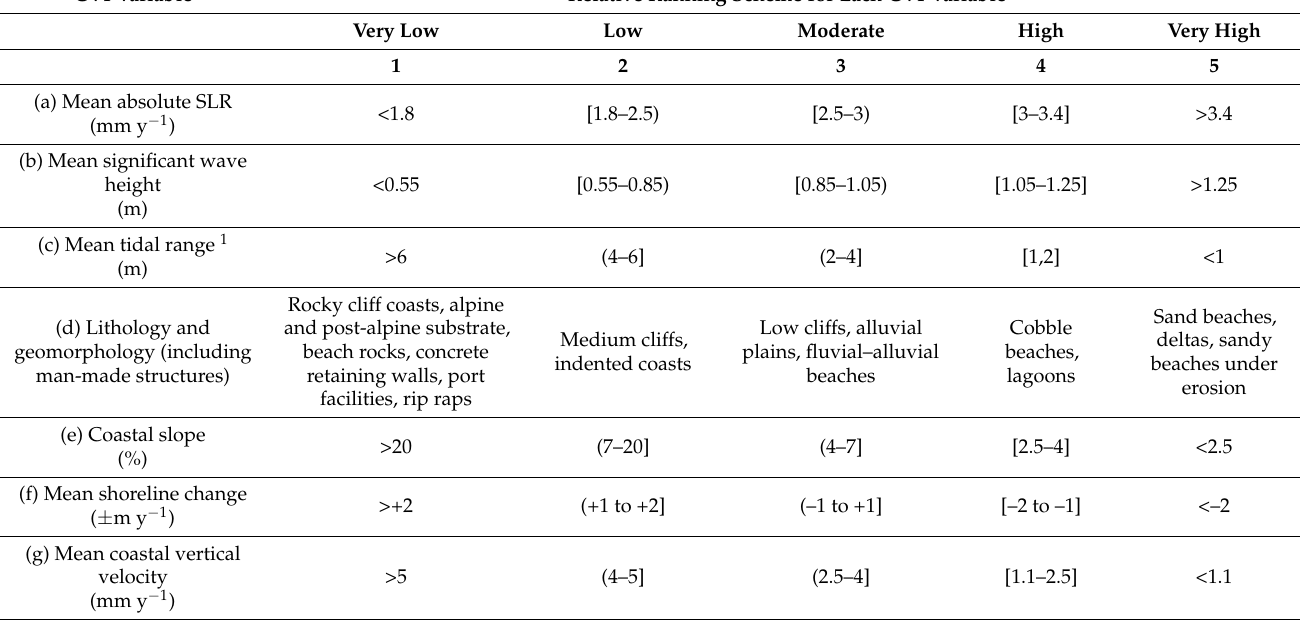
Table 1. Relative vulnerability classes for the CVI variables, implying the importance of their individual contribution to the expected physical coastal changes due to sea level rise (SLR). The physical variables shown together with their thresholds follow the Gornitz [23], Gornitz et al. [48] and Thieler and Hammar-Klose [49] approaches. The suitability of the applied vulnerability ranking scheme for the CVI determination of Rhodes Island is supported by the observations and measurements made during the performance of a plethora of assessment field surveys in the island’s coastal zone as well as by the concepts presented in the studies of Pendleton et al. [52,53], Kaliraj and Chandrasekar [54], Karymbalis et al. [55], Dimou et al. [56], Tragaki et al. [57] and Kantamaneni et al. [58]. Key: [] represents a closed interval; ( ] and [ ) represent half-open